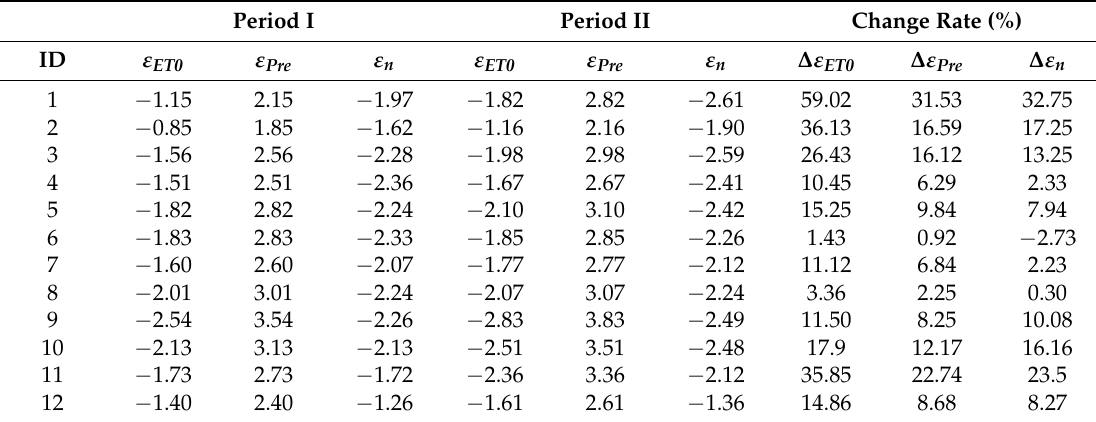
Table 3. The elasticity of naturalized runoff to potential evapotranspiration ( ET 0 ), precipitation ( Pre ), and vegetation ( n ) in 1980–1999 (Period I) and 2000–2013 (Period